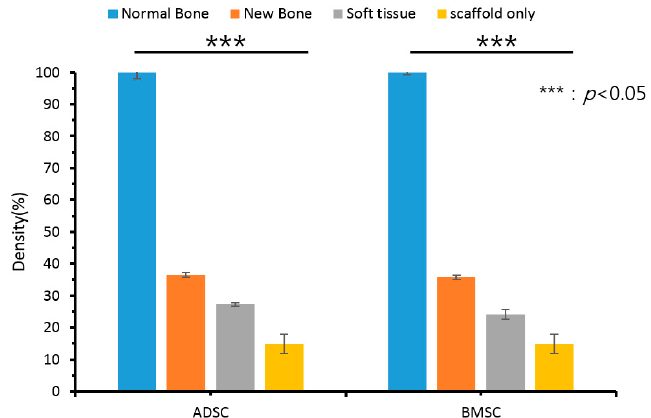
Figure 5. Gray values of normal bone, new bone, and soft tissue from the adipose-derived stem cell (ADSC) and bone marrow stem cell (BMSC) groups.